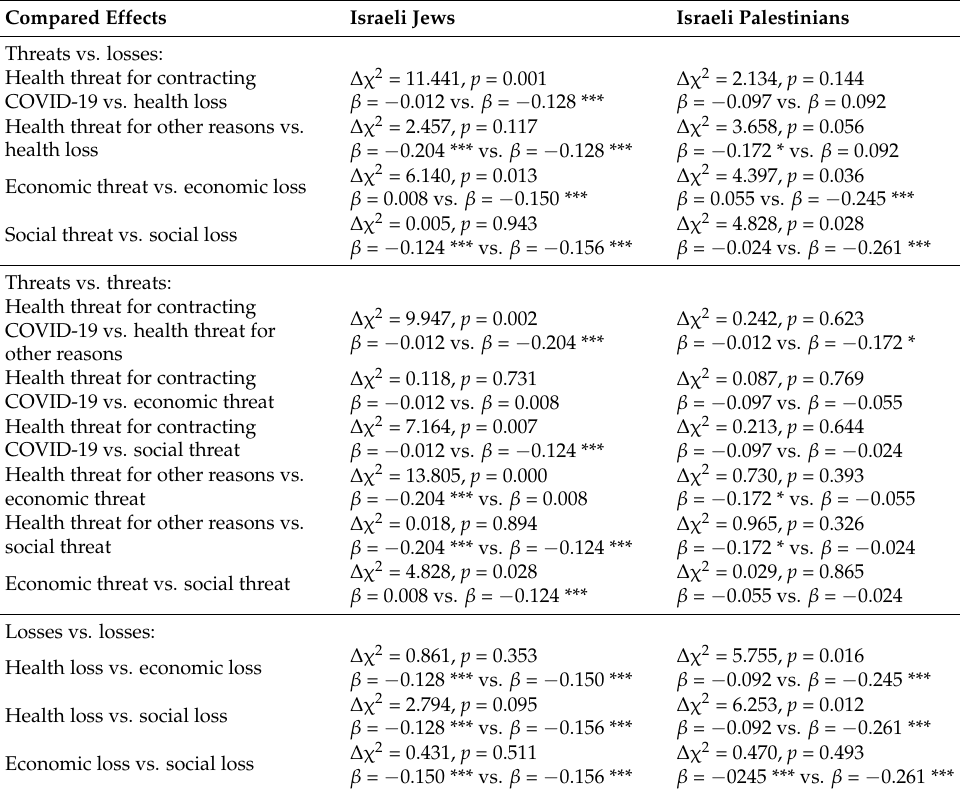
Table 3. Comparison of effect magnitudes on